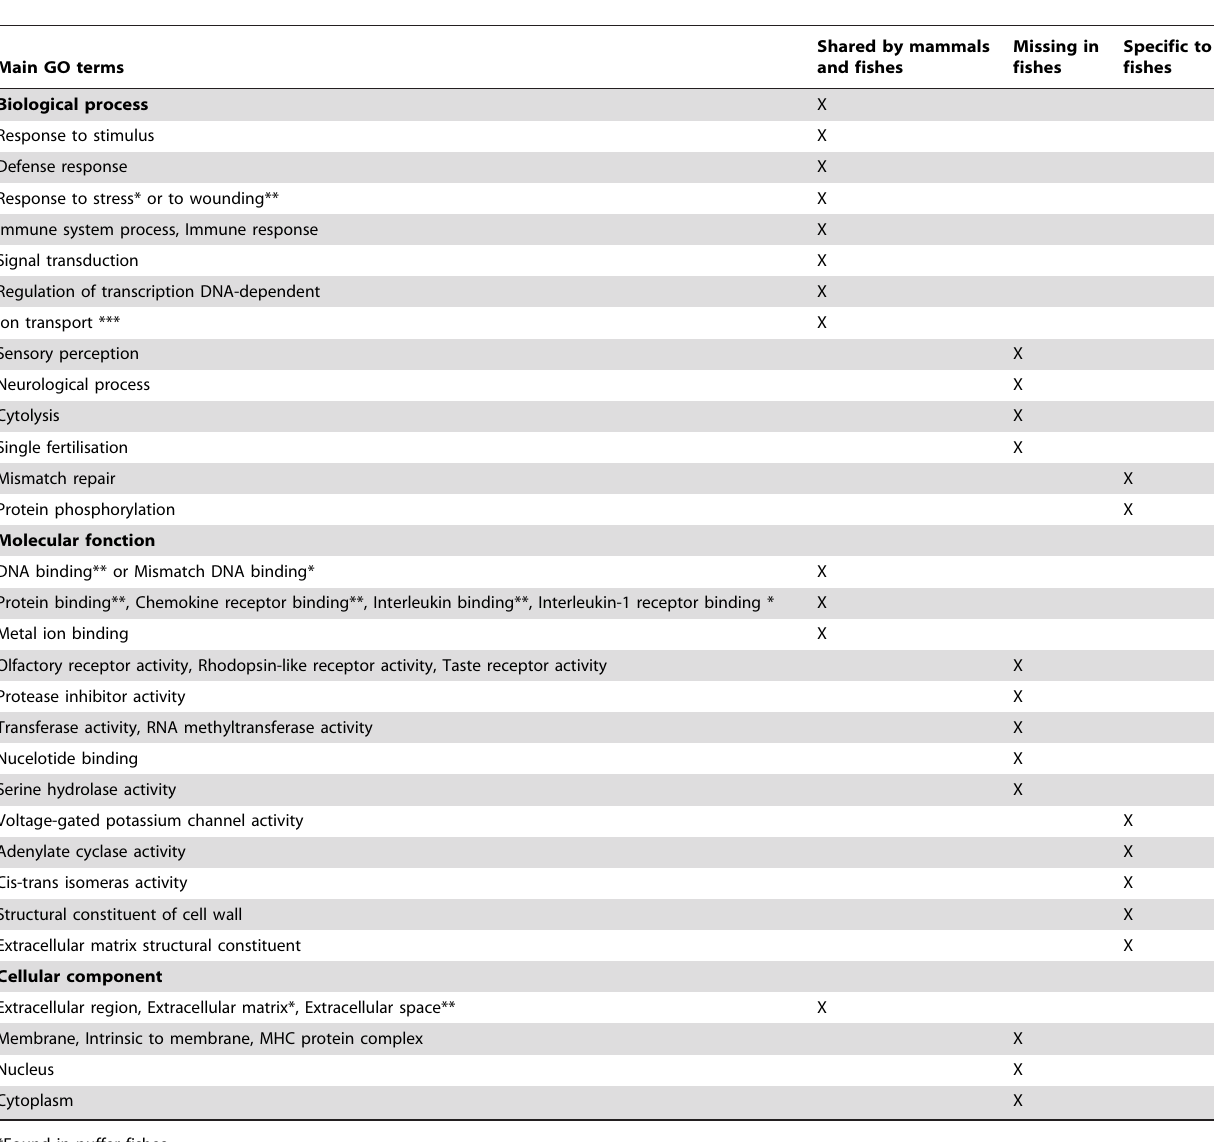
Table 5. Summary of main GO terms enriched in PSG that are shared between mammals and puffer fishes, that are specific to mammals or specific to puffer